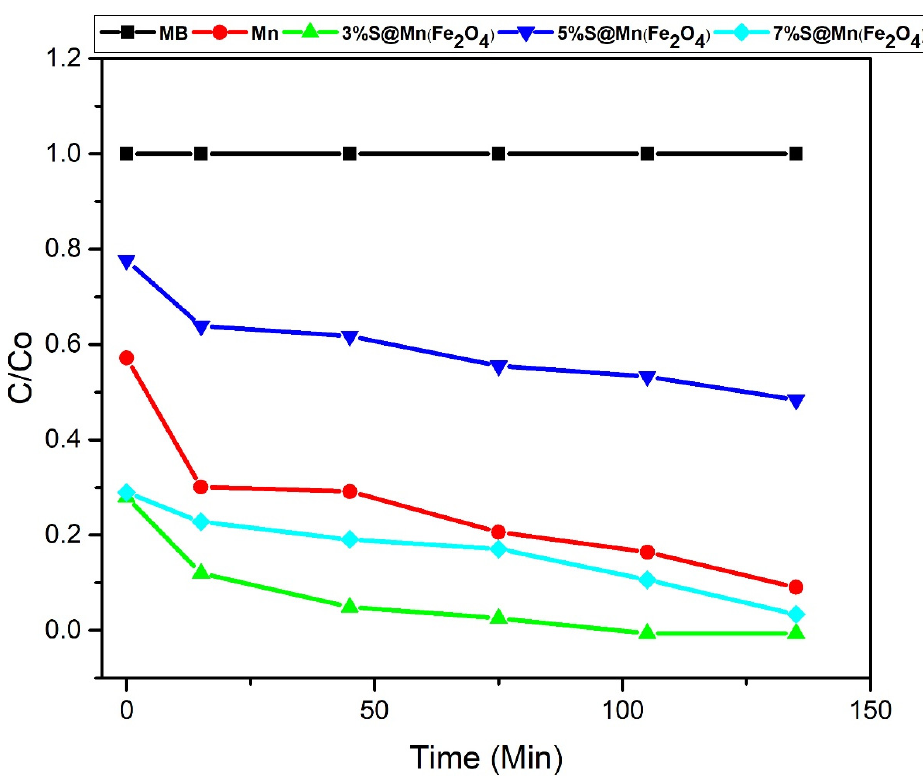
Figure 8. Photocatalytic degradation rate (C e /C o vs. different time intervals).